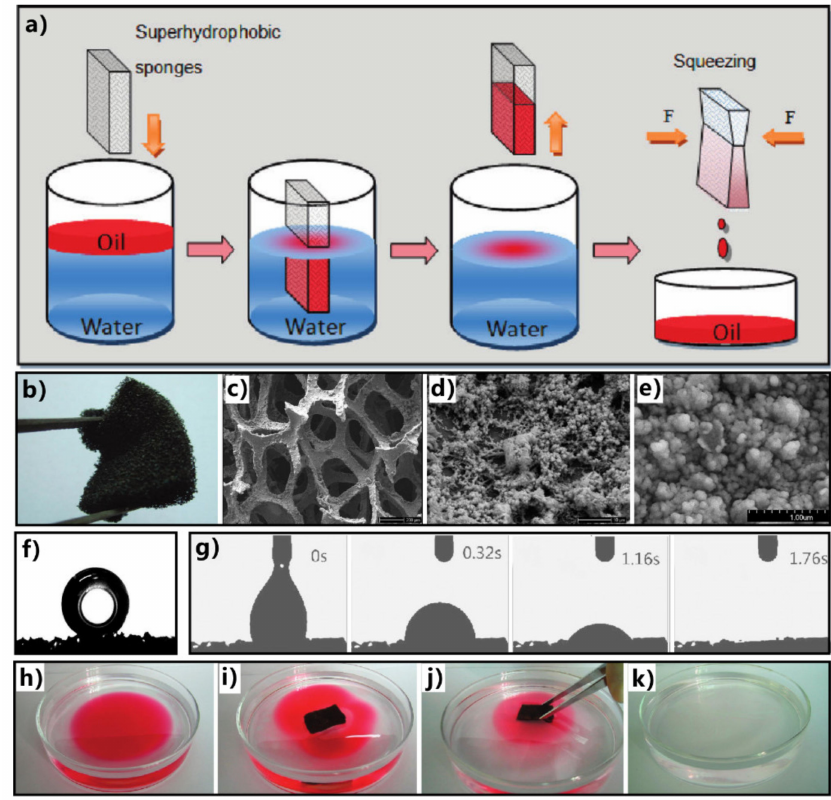
Figure 17. Absorption-based separation of oil from water by a superhydrophobic/superoleophilic sponge. ( a ) Schematic of the process of removing oils from water within a cycle of oil absorption, transportation, and release. ( b ) Photo of the superhydrophobic and superoleophilic porous PU sponge. ( c ) SEM image of the as-prepared sponge. ( d , e ) Surface microstructure of the sponge skeleton. ( f ) Water droplet on the structured sponge. ( g ) Oil being absorbed by the as-prepared sponge. ( h – k ) Using a superhydrophobic sponge to selectively absorbing oil (red color) from the water. Reprinted with permission from ref. [283]. Copyright 2011, American Chemical